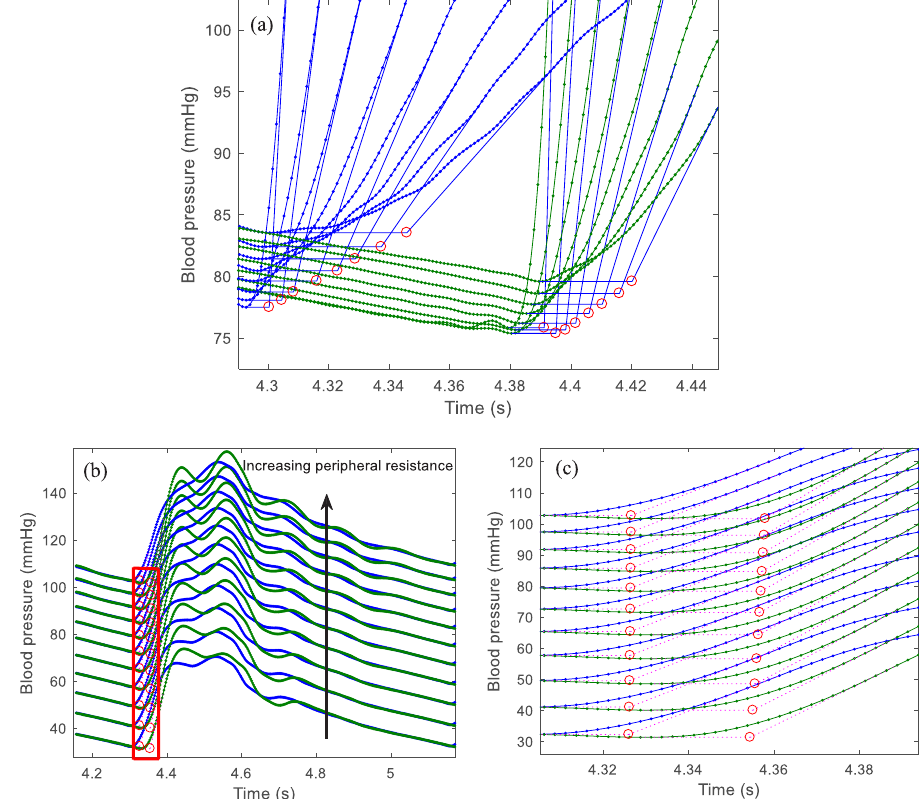
Figure 3. The schematic diagram of the changes of upstroke slopes and pulse foot in ( a ) the pulse waveforms of carotid (blue lines) and femoral (green lines) arteries with LVET and ( b ) the pulse waveforms of ascending aorta (blue lines) and carotid arteries (green lines) with peripheral resistance (( c ) detail with enlarged scale for the red frame in left